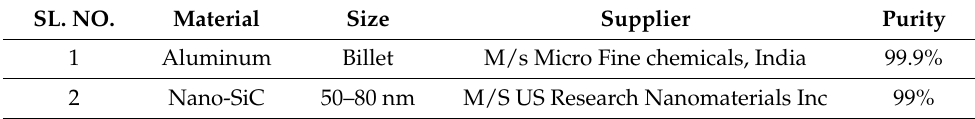
Table 1. Details of aluminum and nano-SiC. SL. NO.